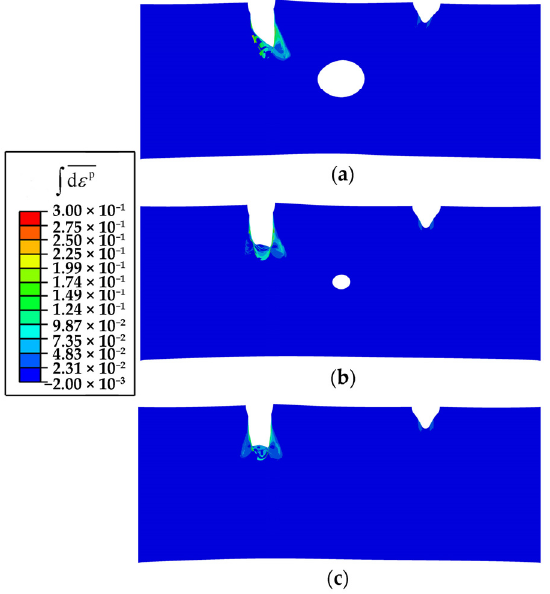
(cid:82) Figure 11. The accumulative plastic strain d ε p of a Mg single crystal in the SCCD process at 0.5 T s: Figure 11. The accumulative plastic strain p d  ε of a Mg single crystal in the SCCD process at 0.5 ( a ) with a cavity ( R = 0.25 µ m), ( b ) with a cavity ( R = 0.1 µ m), and ( c ) without a